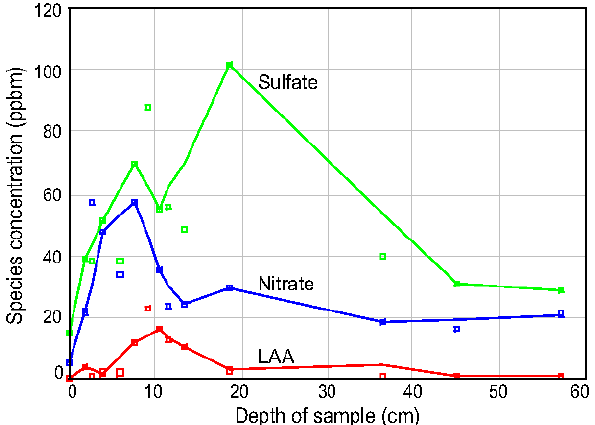
Figure 10 Depth profiles as in Figure 8 but now for the 2009 Canadian data set.